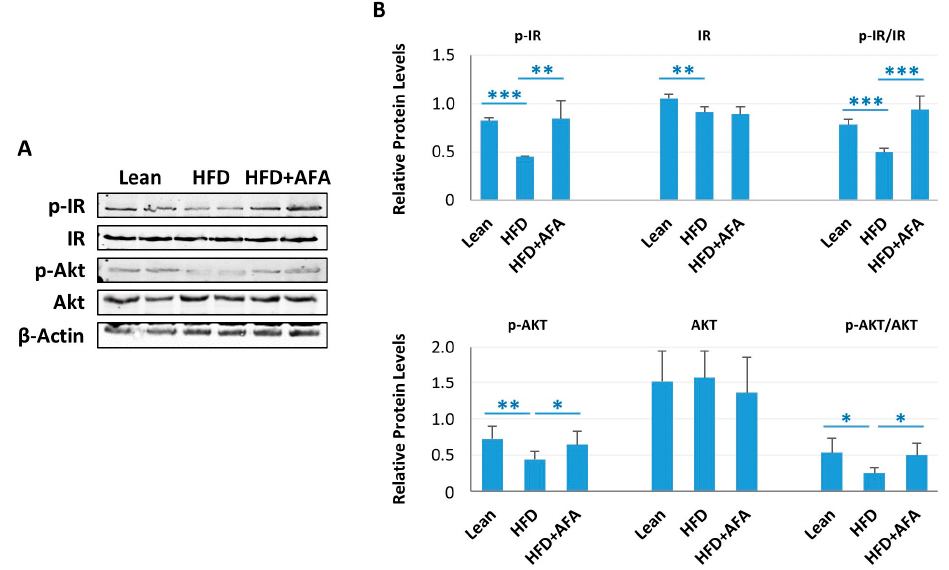
Figure 3. AFA chronic ingestion reduces insulin resistance. ( A ) Immunoblot of total lysate of Lean, HFD and HFD + AFA cortex incubated with anti-IR, anti-phospho-IR (p-IR), anti-Akt, anti-phospho- Akt (p-Akt) and anti- β -actin. ( B ) Quantification of immunoreactivity was performed by using densitometric analysis; uniformity of gel loading was confirmed with β -actin utilized as standard. * p < 0.05, ** p < 0.005, *** p < 0.001 vs. indicated groups.